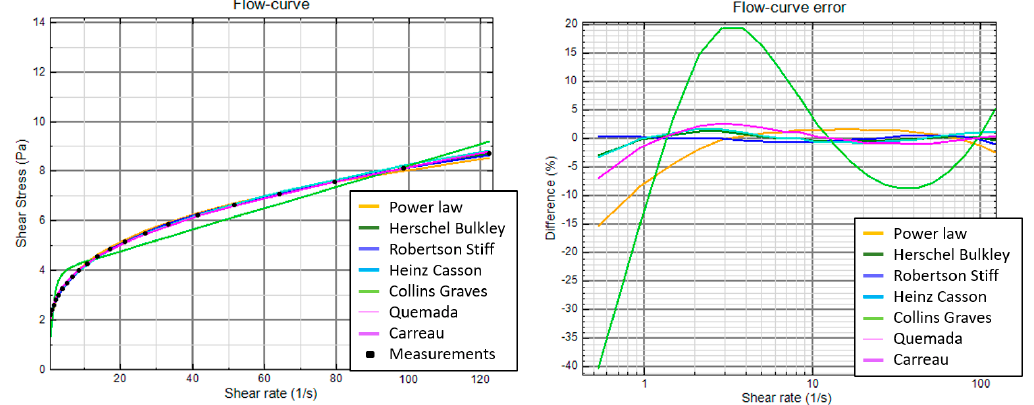
Figure 5. For a KCl / polymer 1500 kg / m 3 at 80 ◦ C, the best match is obtained with a Herschel–Bulkley Figure 5. For a KCl/polymer 1500 kg/m 3 at 80 °C, the best match is obtained with a Herschel–Bulkley rheological rheological behavior.